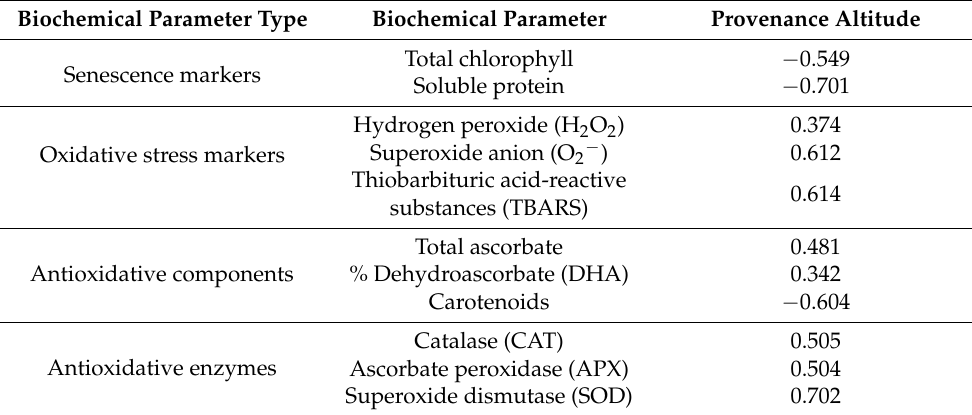
Table 3. Pearson’s correlation coefficients (r) among provenance location altitudes and biochemical parameters (senescence markers, oxidative stress markers, antioxidative system components) in senescing beech